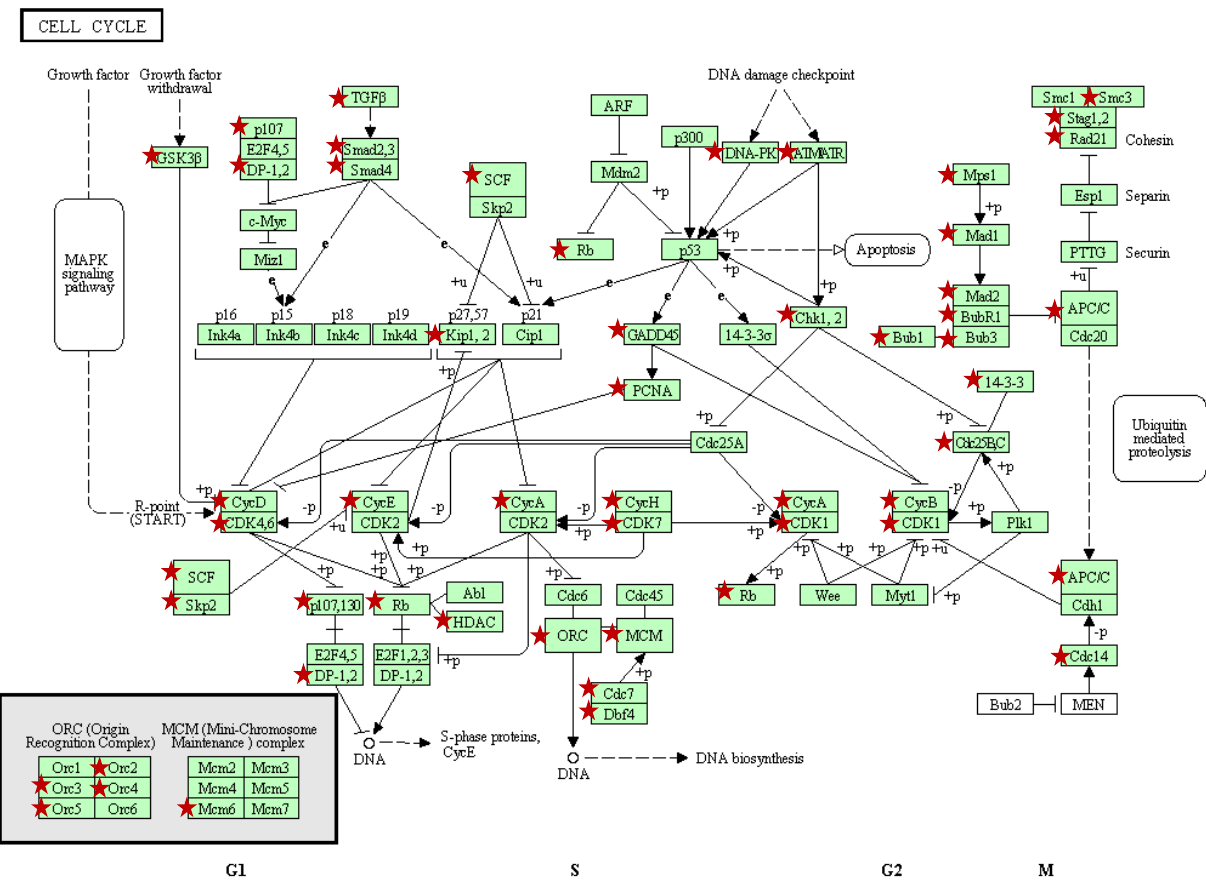
Figure 1. Cell cycle pathway represented in KEGG [24,25]. Red stars mark genes down regulated following PAC treatment of NCI-H460 cells compared to vehicle treated cells based on global gene expression results. As illustrated, PAC alters expression of a large number of genes involved in all phases of cell cycle regulation, including the G1/S and G2/M transitions and DNA